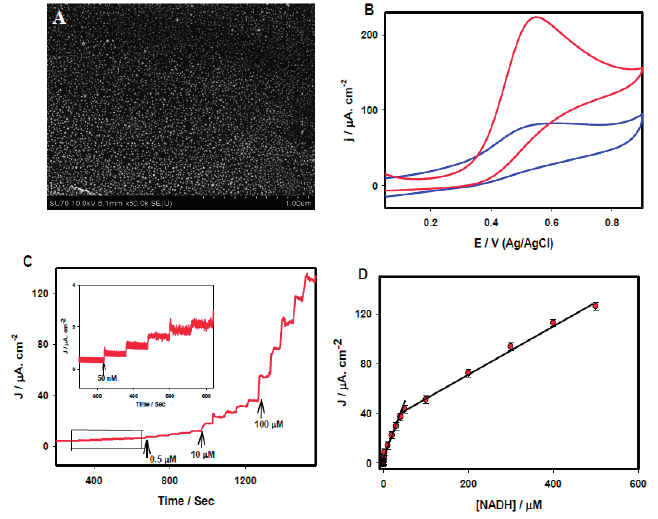
Figure 5. ( A ) FE-SEM images of the AuNP-rGO on the GCE surface. ( B ) CVs recorded at the rGO/GCE (blue), and AuNPs-rGO/GCE (red) recorded in 1 mM NADH. ( C ) Amperometric i-t curve recorded at the Au-rGO/GCE in 0.1 M PBS under various NADH concentrations (50 nM–0.5 mM), Eapp: 0.55 V and ( D ) the calibration plot of current density vs . NADH concentration. All figures are reproduced with permission from [25]. Copyright 2015